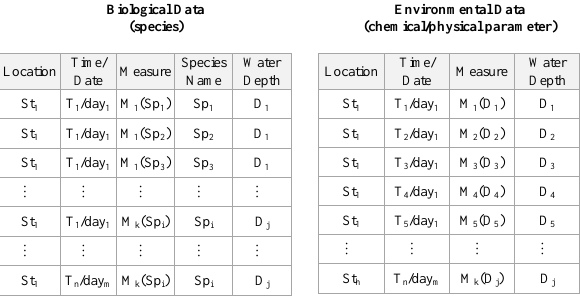
Figure 1. General attribute structure of limnological